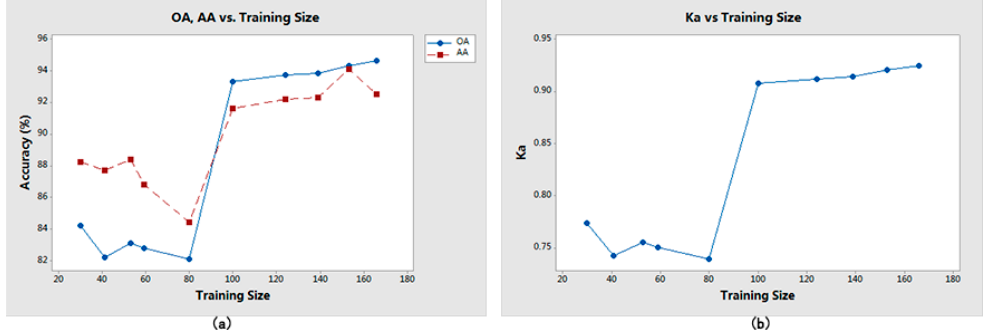
Figure 10. Relationship between the training size and accuracy: ( a ) OA, AA vs. training size; ( b ) Ka vs. training size.